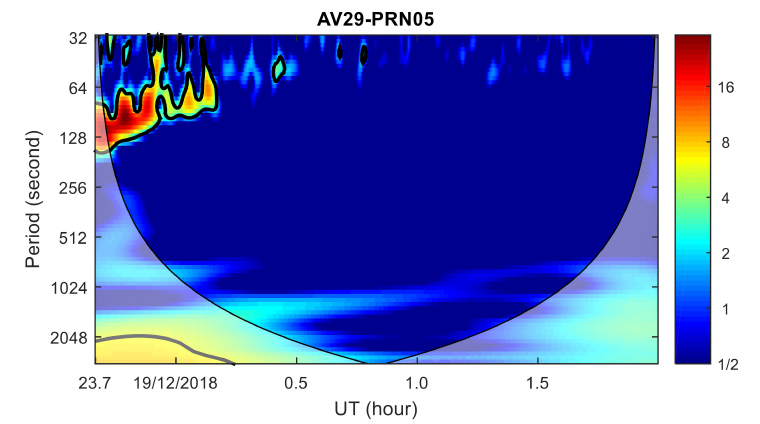
Figure 11. Wavelet transform power spectrum of TEC time series at AV29 station. Shadow region regions on either end indicate the “cone of influence”, where edge e ff ects become important.